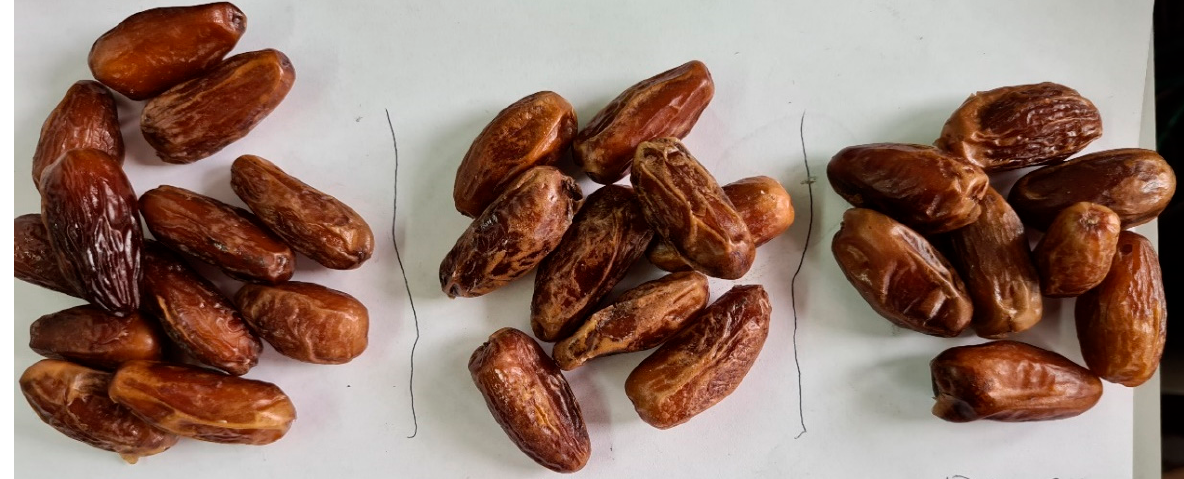
Figure 10. Experiment at 8 MPa and 1.7 kW US at different processing times (1, 3 and 5 min).